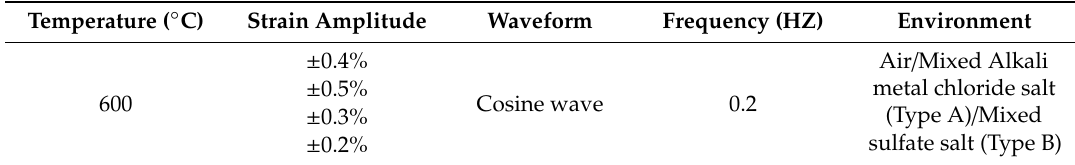
Table 2. Fatigue experimental scheme of 12Cr1MoV alloy.